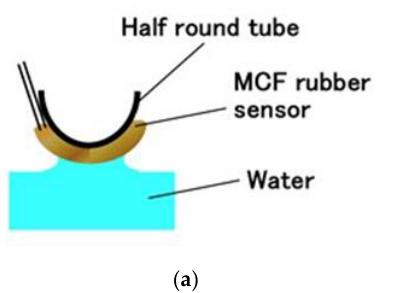
Figure 17. Schematic diagram for MCF rubber sensor in contact with water: ( a ) at time of sensor’s touching to water; ( b ) after sensor’s touching and then insertion to water.